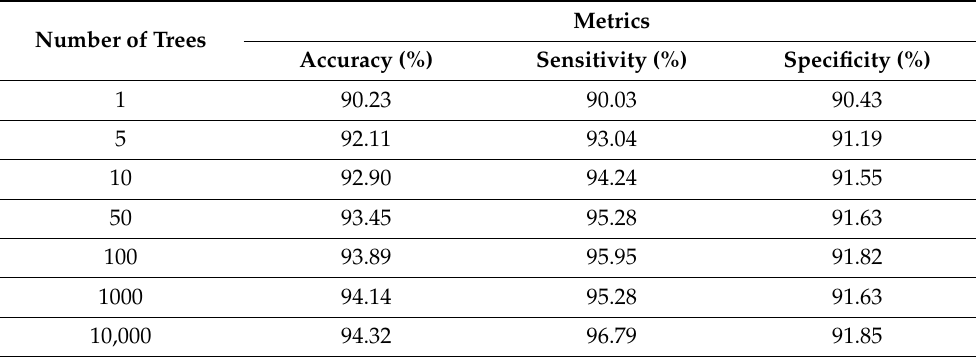
Table 1. Accuracy, Sensitivity, and Specificity of Random Forest classifiers using the OULAD dataset. Number of trees represents the number of trees generated by Random Forest. The metrics are averaged with respect to the number of cross-validation (50).